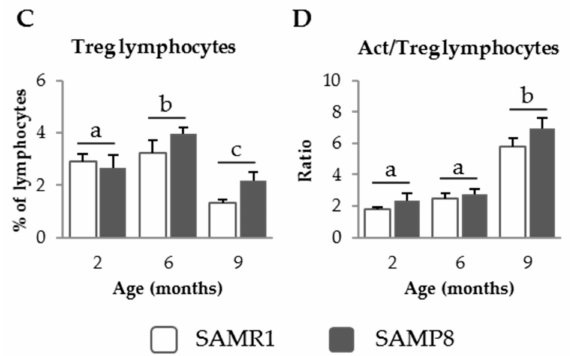
Figure 2. Cell recruitment ( A ); percentage of activated (Act.) Th lymphocytes ( B ); percentage of regulatory (Treg) Th lymphocytes ( C ); and the ratio of activated to regulatory Th lymphocytes ( D ), in Peyer’s patches (PP) of SAMR1 and SAMP8 mice at 2, 6, and 9 months of age. The open bars represent SAMR1 mice; the solid bars, SAMP8 mice. Results are expressed as means ± SEM ( n = 5–10 animals). Means without a common letter differ, p < 0.05. Int., interaction between factors (age and mice strain).